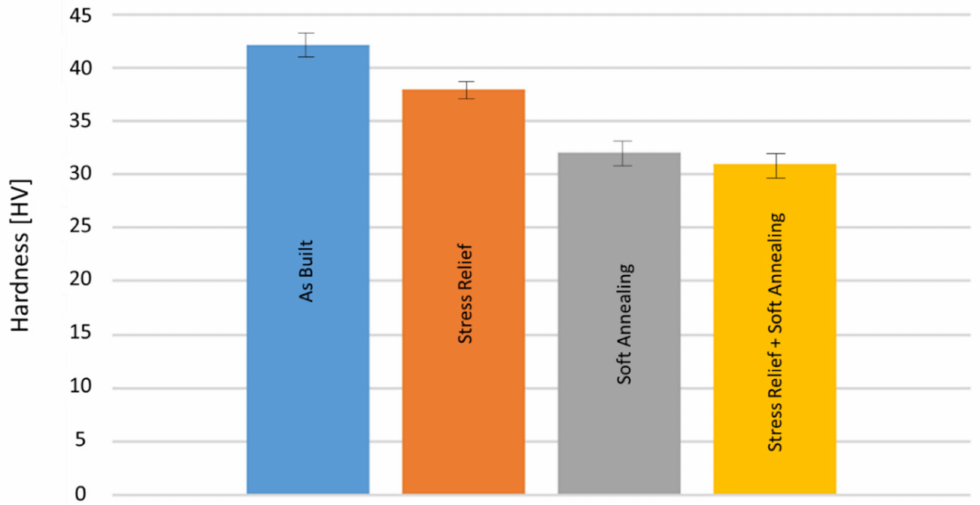
Figure 8. Microstructure of heat treated samples, the arrow indicates the build direction.